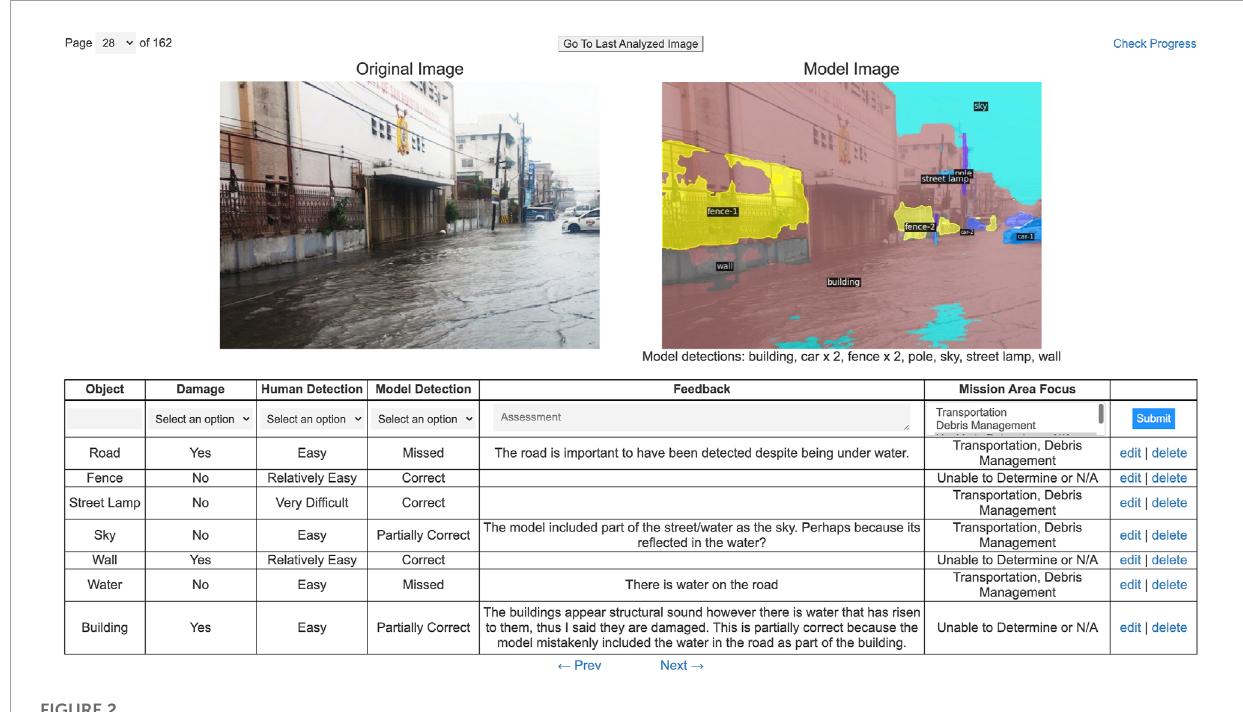
FIGURE 2 Web user